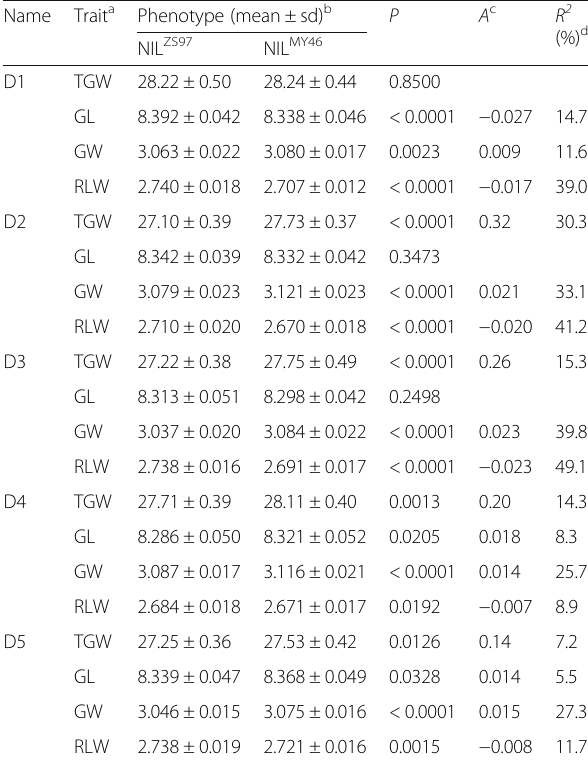
Table 3 Dissection of qTGW1.2c into two QTL using five sets of near isogenic lines in BC 2 F